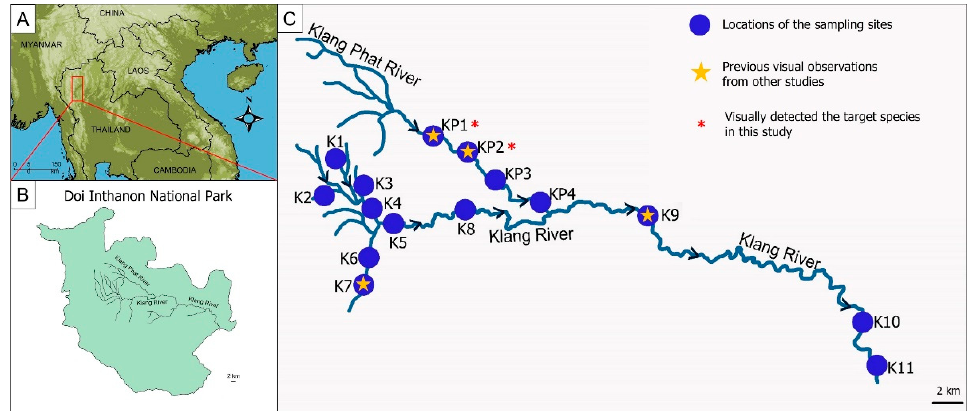
Figure 1. Locations of the sampling sites with indication of previous visual observation. ( A ) Map of Thailand, ( B ) a general map of the Doi Inthanon National Park with details of the Klang Phat River and Klang River, ( C ) location of the sampling sites (N = 15) and visual detection of the target species in this study (N = 2) across the Klang Phat River and Klang River in the Doi Inthanon National Park, Chiang Mai, Thailand.